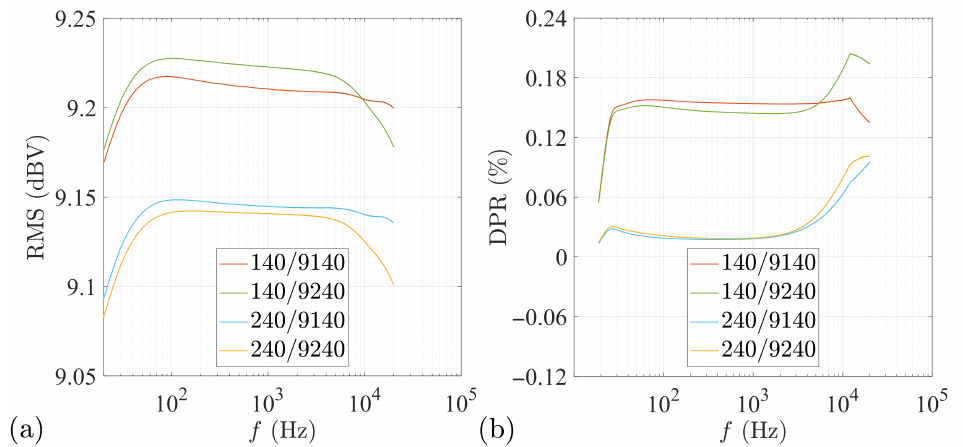
Figure 10. Measured: ( a ) RMS and ( b ) DPR of the LF